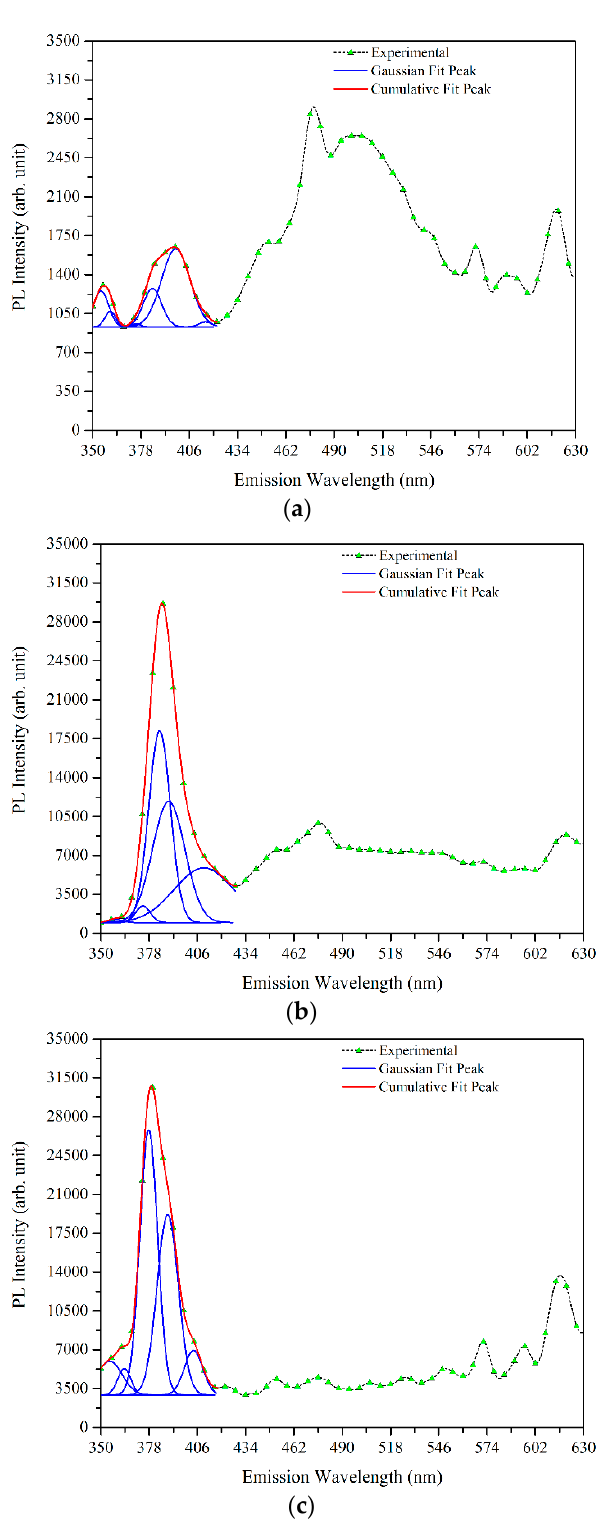
Figure 9. PL analyses of the prepared ZnO samples grown at: ( a ) 500 ˝ C; ( b ) 600 ˝ C; and ( c ) 700 ˝ C. The Gaussian deconvoluted spectra exhibit multi emission traps in the UV range from 350 nm to 370 nm and from 370 nm to 390 nm. These multi emission traps (blue lines) can be overlapped and combined to form a prominent peak (red dot line), which can be seen in Figure 9. The former range emission can be associated with the interband transition of the photogenerated electrons and holes. Relatively, a considerably stronger irradiation of excitation light will create a quasi Fermi level inside the conduction band. Therefore, the recombination of electron-hole pairs from this level to valence band will emit a photon energy that is greater than the ZnO energy band gap (3.37 eV) [41,42]. The latter range emission dovetails to the near band edge emission, which arises from the recombination of free excitons through an exciton-exciton collision process. The width of the UV emission indicates that the peak consists of sundry emissions. The emissions can be assigned to the two-phonon replicas due to the two transverse optical phonons within a range of separation from 50 meV to 110 meV [22]. The PL spectra also revealed a broad range of visible emission. Several defect-related recombination centers, such as Zn vacancy ( V Zn ), oxygen vacancy ( V O ), interstitial Zn ( Zn i ), interstitial oxygen ( O i ), Zn antisite ( Zn O ), and oxygen antisite ( O Zn ) defects were responsible for the luminescence process of ZnO in the visible region of electromagnetic radiation [43]. Among the defects, Zn O , is unlikely to be stabilized under equilibrium conditions ascribed to their high formation energies. Additionally, Zn i and V O can yield free electrons (donor type defects), whereas V Zn , O i , and O Zn consume free electrons (acceptor type defects) in a ZnO crystal. The relative content of donors and acceptors determines the semiconductive property and further semiconductor-related properties of ZnO [44,45]. The observed PL spectra revealed emission band at 390 nm to 455 nm (violet luminescence) is probably attributed to the radiative defects related to the interface traps existing at the grain boundaries and emitted from